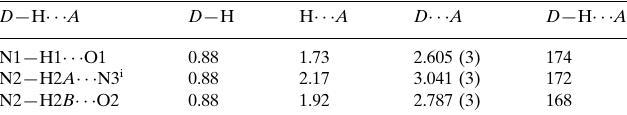
Hydrogen-bond geometry (A˚ , (cid:3)